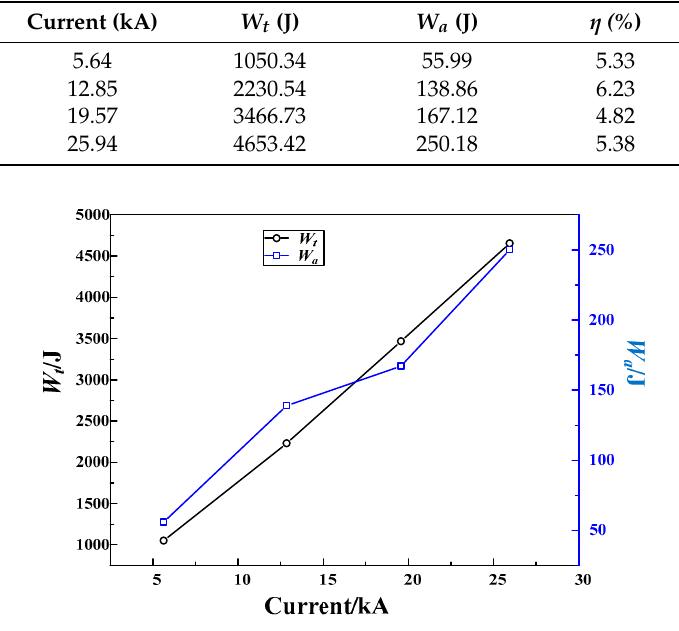
Figure 11. The relationship between energy and current.